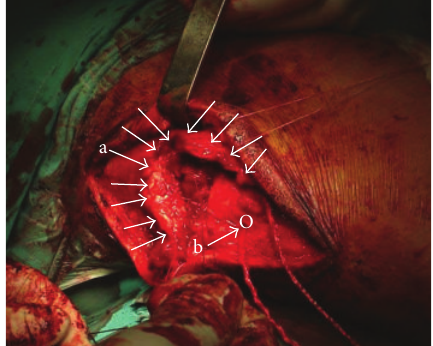
Figure 2: Intraoperative aspect indicating (a) the ruptured and retracted distal triceps tendon and (b) the synthetic tendon allograft already positioned through the olecranon (O). Suture anchors were placed